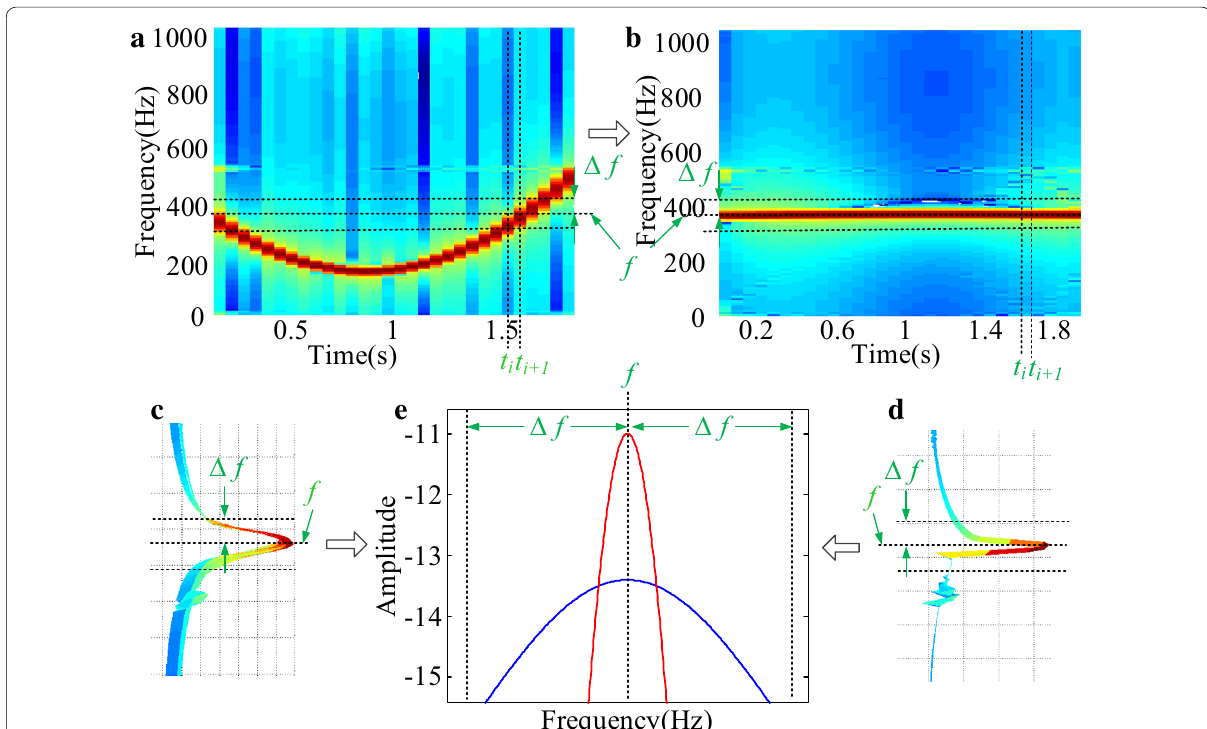
Figure 4 Illustration of GDT: a TFR of raw signal; b TFR of demodulated signal; c Partial enlarged drawing of TFR of raw signal; d Partial enlarged drawing of TFR of demodulated signal; e Amplitude comparison